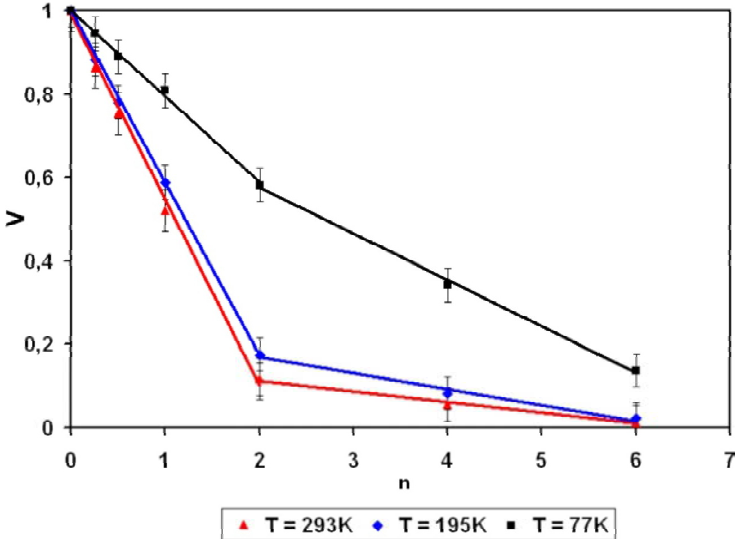
Fig. 3. Dependences of V(n) after the HPT of the crystalline Ti